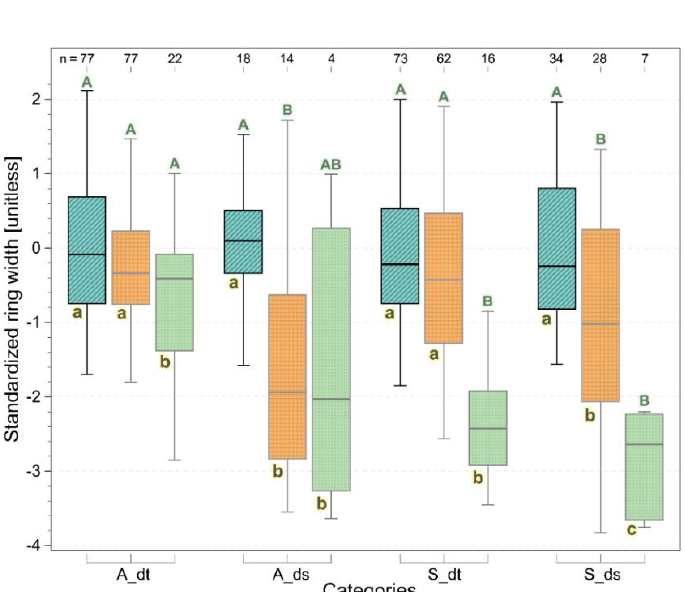
Figure 4. Boxplots of standardized ring width and comparison between samples grouped according to symptomatology, drought sensitivity, and year type (normal years (cyan, lines), drought years (orange, grid), and 2019 (green, dots)). A_dt (asymptomatic drought-tolerant), A_ds (asymptomatic drought- sensitive), S_dt (symptomatic drought-tolerant), and S_ds (symptomatic drought-sensitive). The drought year 2019 is considered separately because of the symptom appearance in the symptomatic and FDp-infected specimens. The letters indicate differences (Kruskal–Wallis paired-test, p < 0.05) between-groups (uppercase) or within-group